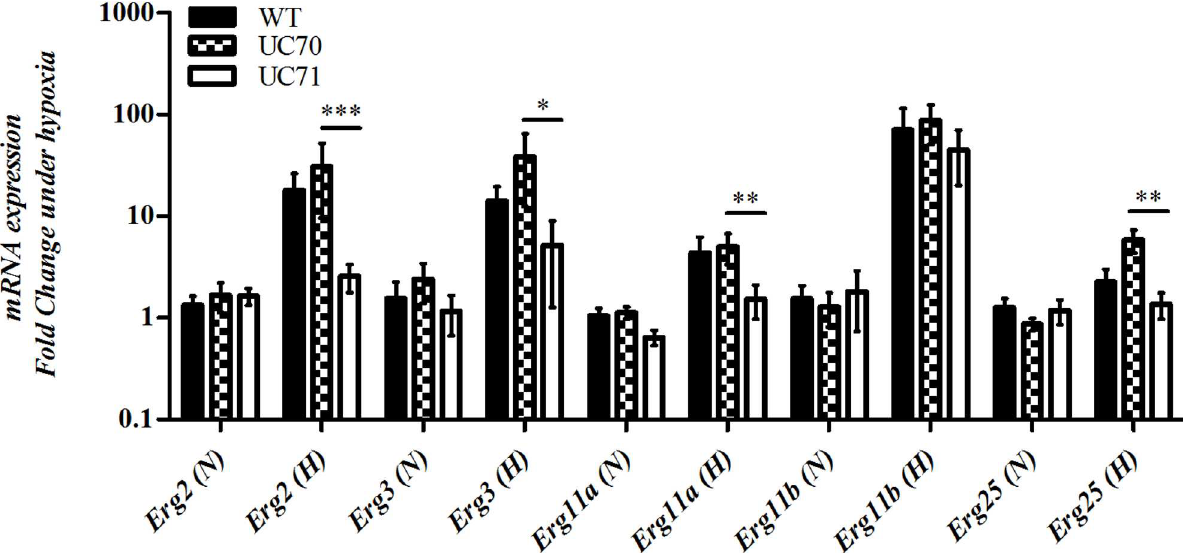
Fig 3. Srb1 regulation of ergosterol biosynthesis genes during hypoxia. Expression of ergosterol pathway genes Erg2 , Erg3 , Erg11 , and Erg25 under normoxia compared to 8 hours of hypoxia. Values in parenthesisrepresent (N) normoxia and (H) hypoxia. Data represent the means and SEM of 3